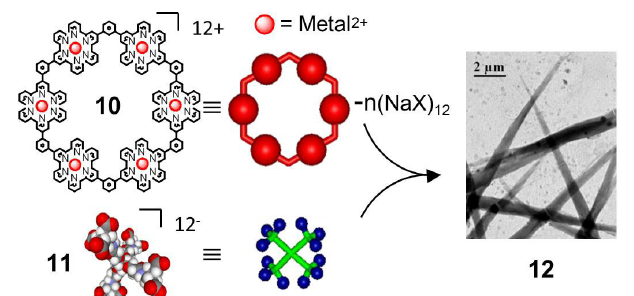
FIGURE 8 – Self-assembly of a dendrimer hexamer composite [Wang, P.; Moorefield, C. N.; Jeong, K.-U.; Hwang, S.-H.; Li, S.; Cheng S. Z. D.; Newkome, G. R. Adv. Mater. , v.20, p.1381-1385, 2008. – Reproduced by permission of